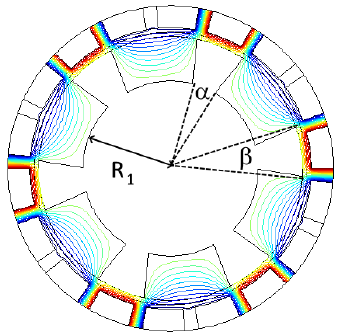
Figure 1. Parametric variables of the electrocstatic motor.